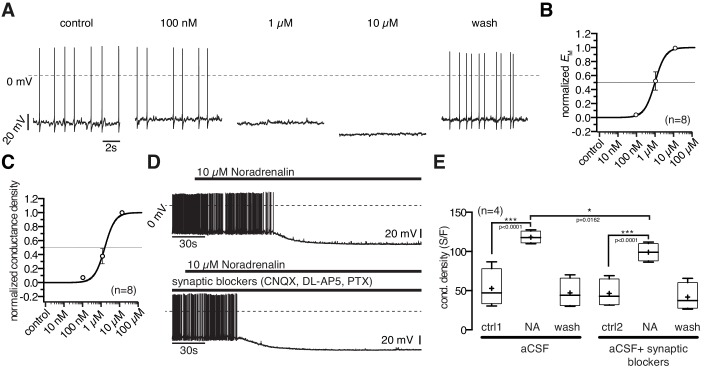
Noradrenergic modulation of POMC neurons is concentration dependent.(A) Recording of a POMC neuron demonstrating the effect of increasing NA concentrations. (B) and (C) Concentration - response relations showing the NA effect on membrane potential (B) and conductance density (C). The curves are fits to a sigmoidal relation (Equation 1). NA had an EC50 of 0.9 µM (0.6–1.5 µM; n = 8) for the membrane potential and 1.3 µM (1.0–1.9 µM; n = 8) for the conductance density, respectively. (D) and (E) The NA modulation of POMC neurons is direct and not dependent on synaptic input. Original recording (D) and averaged effect on conductance density (E) showing that the NA effect on POMC neurons is not changed when glutamatergic and GABAergic synaptic input is blocked. Experiments shown in (E) were performed consecutively with the same set of neurons (n = 4). Control 1 and control two refers to the different starting conditions, that is pre-incubation with or without synaptic blockers. **p<0.01; ***p<0.001; one-way ANOVA with post hoc Tukey analysis.